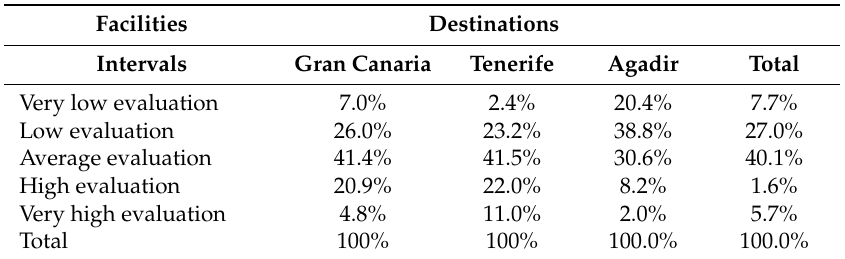
Table 5. Comparative analysis of the facilities